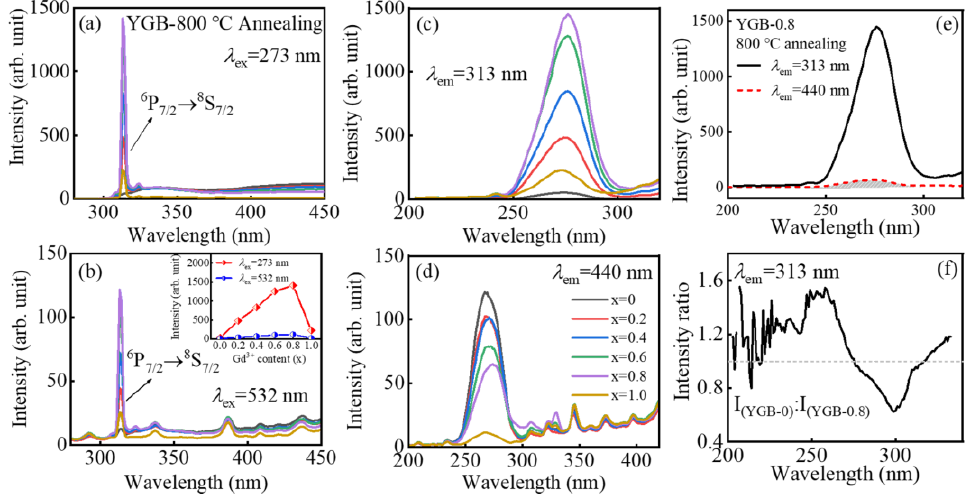
Figure 5. PL spectra of YGB phosphors (x = 0, 0.2, 0.4, 0.6, 0.8, and 1.0) under the ( a ) 273 nm and ( b ) 532 nm excitations, and their PLE spectra monitoring at ( c ) 313 nm and ( d ) 440 nm. Inset in ( b ): The dependence of PL emission intensities at 313 nm on the Gd 3+ content (x) in YGB phosphors under 273 nm and 532 nm excitations. ( e ) Excitation spectra of YGB-0.8 phosphor with the spectral overlap presented by the shade and ( f ) the fluorescence intensity ratio of the 800 °C annealed YGB-0.8 and YGB-0 phosphors monitored at 313 nm.